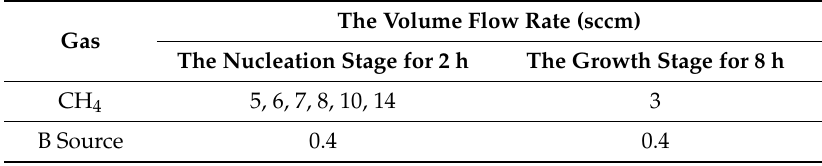
Table 1. Deposition parameters of the variation of CH 4 flow rate in the nucleation